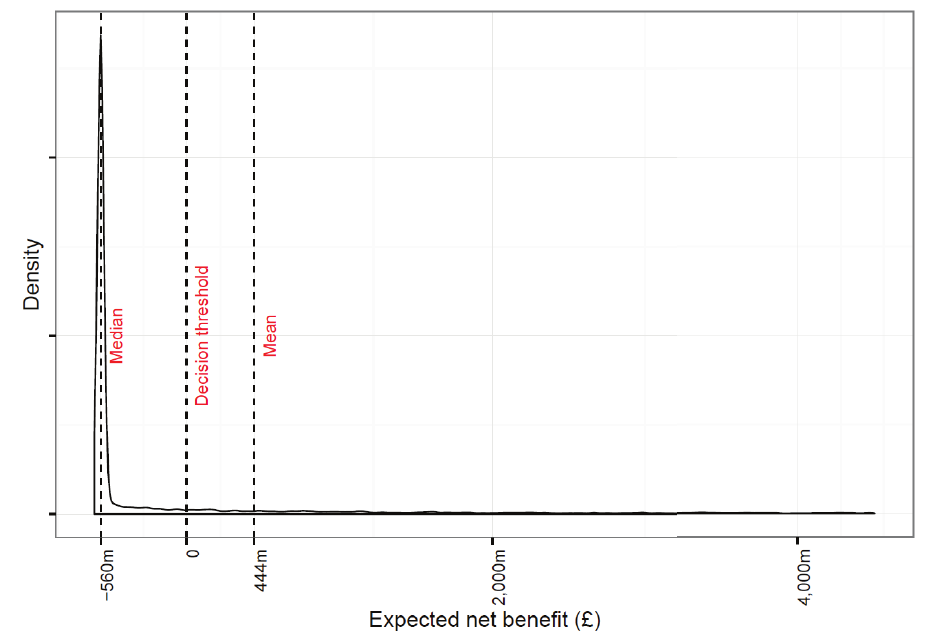
Figure 2. Posterior distribution of the loss function for stockpiling NAIs showing the mean and median values of the distribution along with the decision threshold for stockpiling. The x-axis has been truncated at